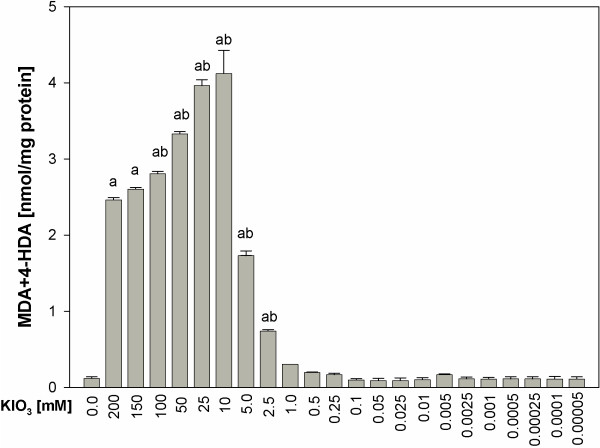
Lipid peroxidation, measured as MDA + 4-HDA level, in porcine thyroid homogenates. Homogenates were incubated in the presence of KIO3 alone [200; 150; 100; 50; 25; 10; 5.0; 2.5; 1.0; 0.5; 0.25; 0.1; 0.05; 0.025; 0.01; 0.005; 0.0025; 0.001; 0.0005; 0.00025; 0.0001; 0.00005 mM]. Data are expressed as nmol/mg protein. Data are from five independent experiments. Values are expressed as mean ± SE (error bars). ap < 0.05 vs. control (in the absence of KIO3); bp < 0.05 vs. any other KIO3 concentration.